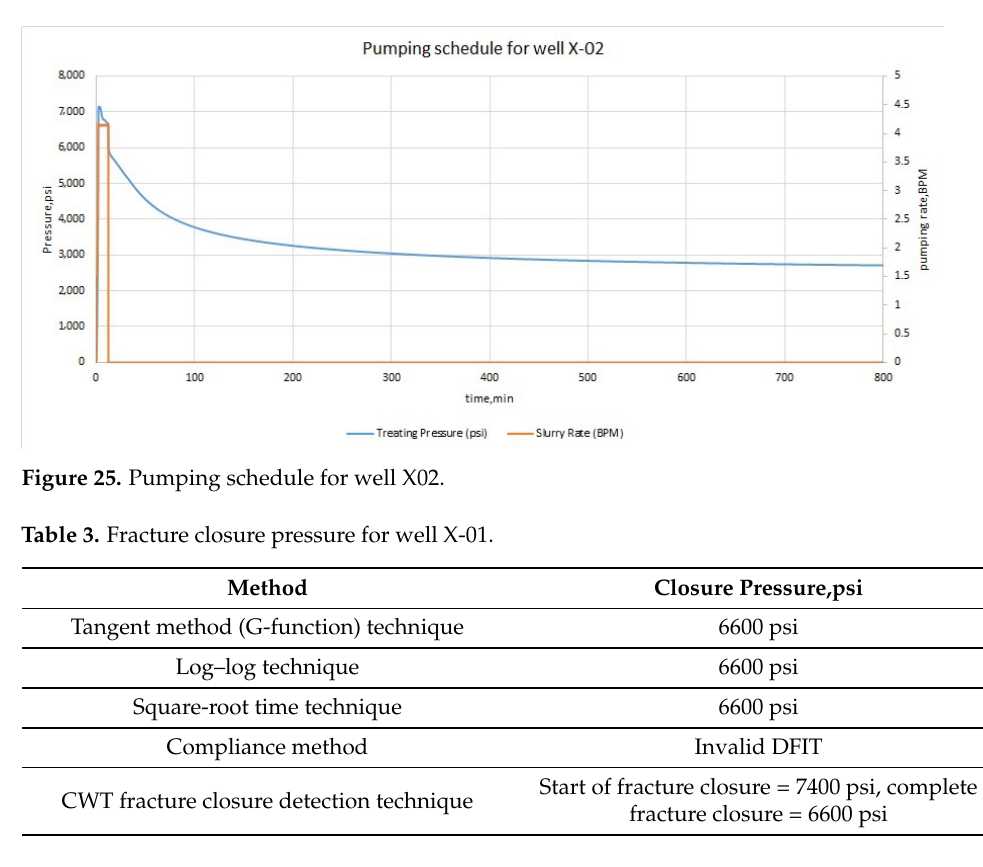
Figure 24. Closure detection using the square root time method for well X-01.